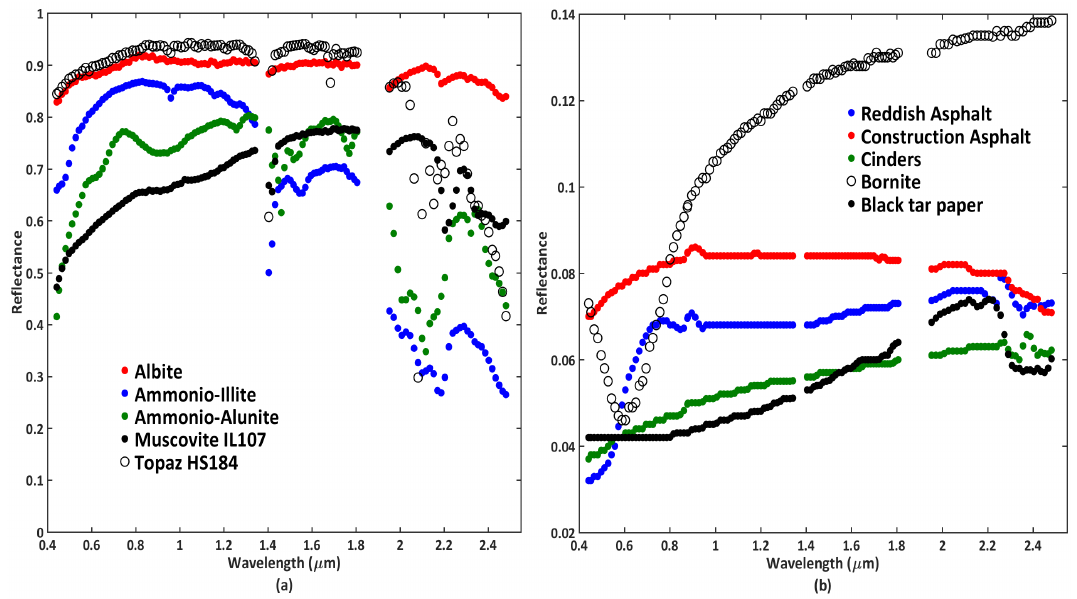
Figure 6. Spectra of the materials ( a ) to generate the bright surface and ( b ) to generate the dark target surface.